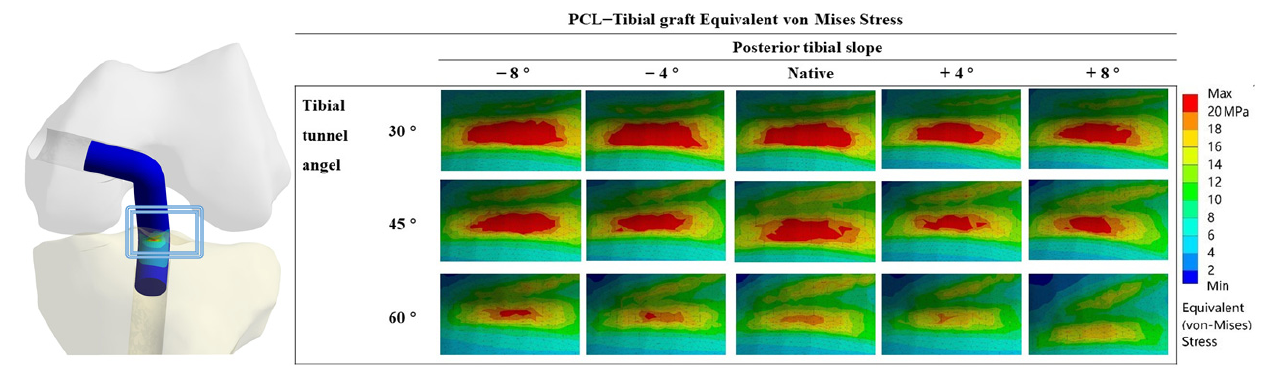
Figure 2. PCL graft equivalent Von Mises Stress distribution around the tibial tunnel entrance after PCL reconstruction.